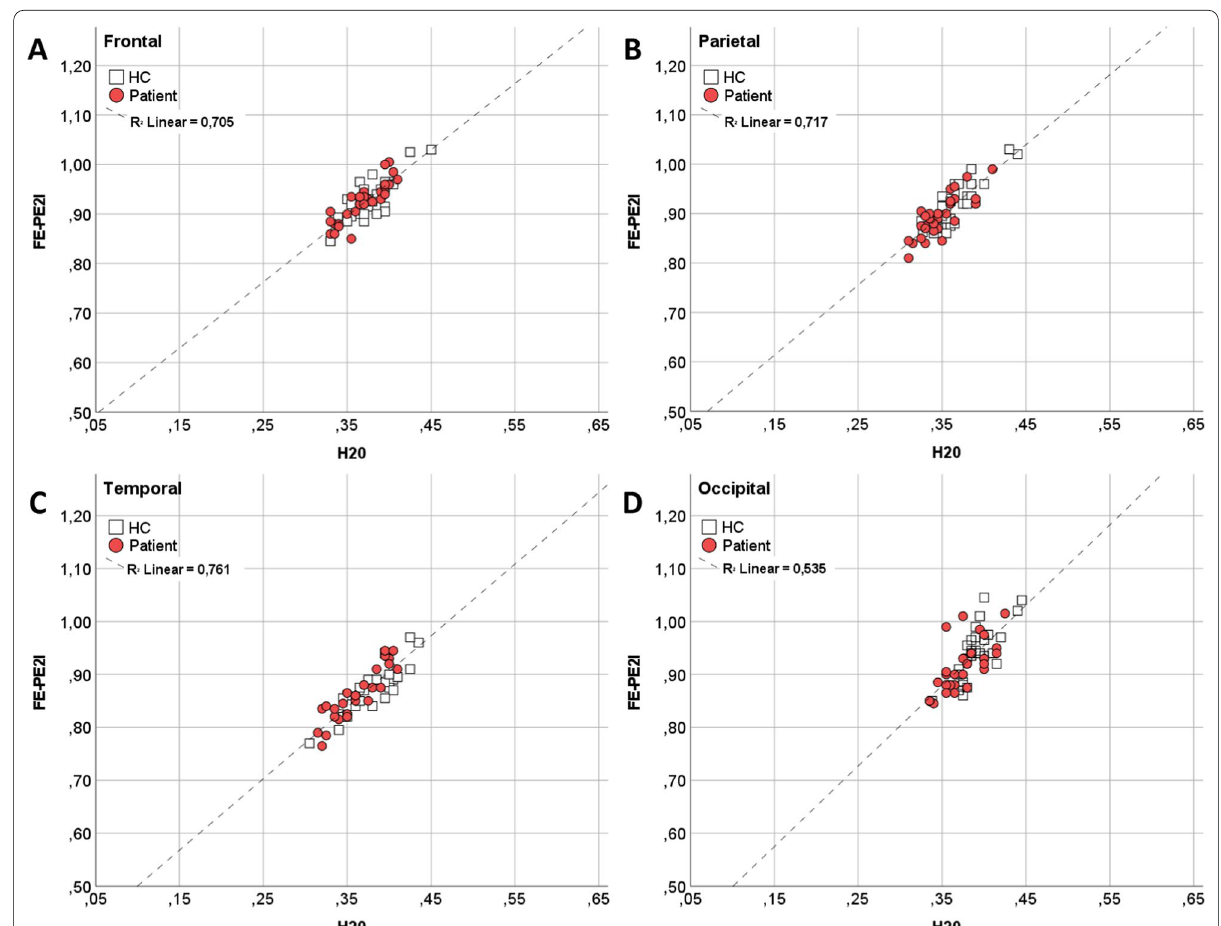
Fig. 2 Correlation plots of R1 (FE-PE2I) and F (H 2 O). Legend ( A ) Frontal cortex, ( B ) parietal cortex, ( C ) temporal cortex, ( D ) occipital cortex. Values are averaged over the left and right